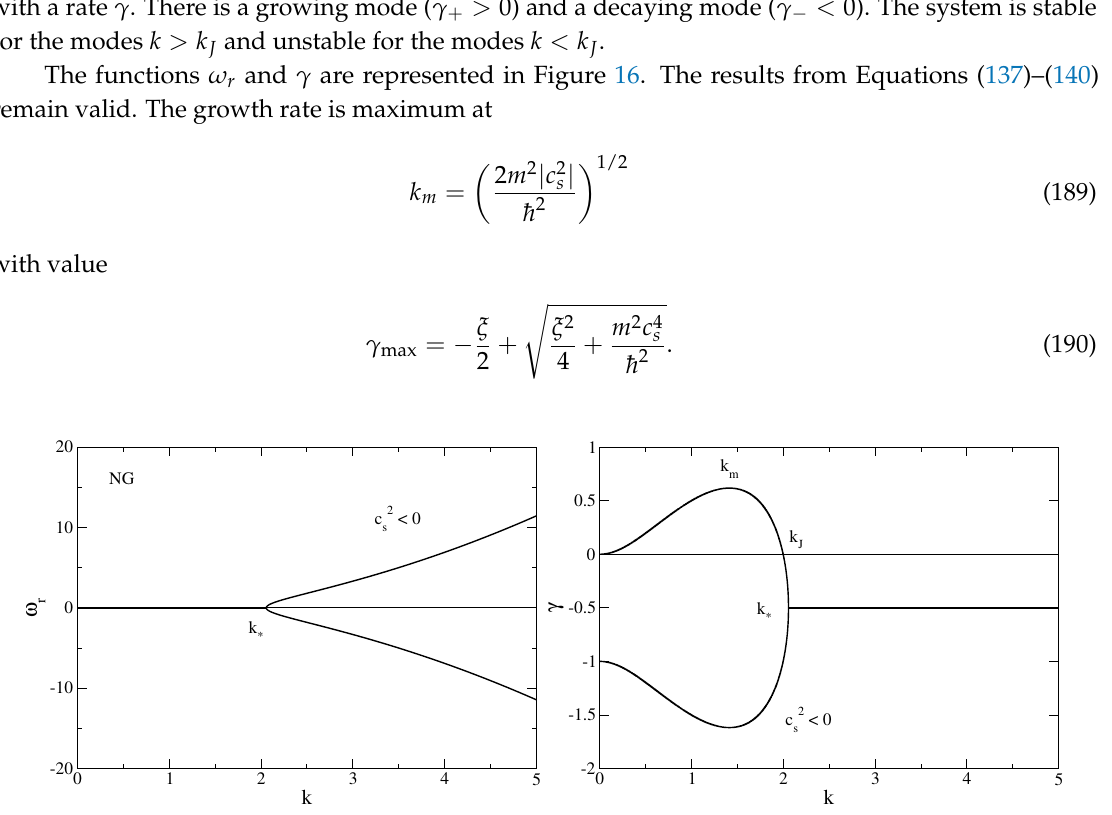
Figure 16. Dispersion relation for BECs in the nongravitational limit ( G = 0) when c 2 s < 0. We have normalized the wavenumber by ( m 2 | c 2 s | /¯ h 2 ) 1/2 and the pulsation and the friction by m | c 2 s | /¯ h . This is equivalent to taking m = | c 2 s | = ¯ h = 1 in the dimensional equations. We have selected ξ =